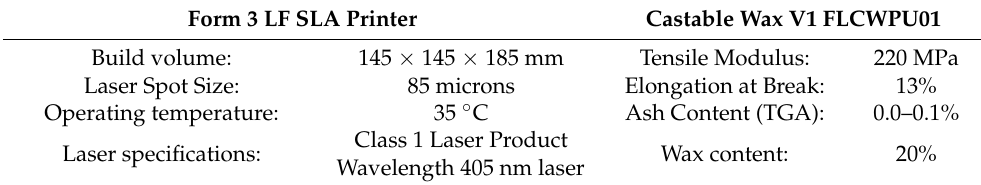
Table 6. SLA printer and Castable Wax characteristics.